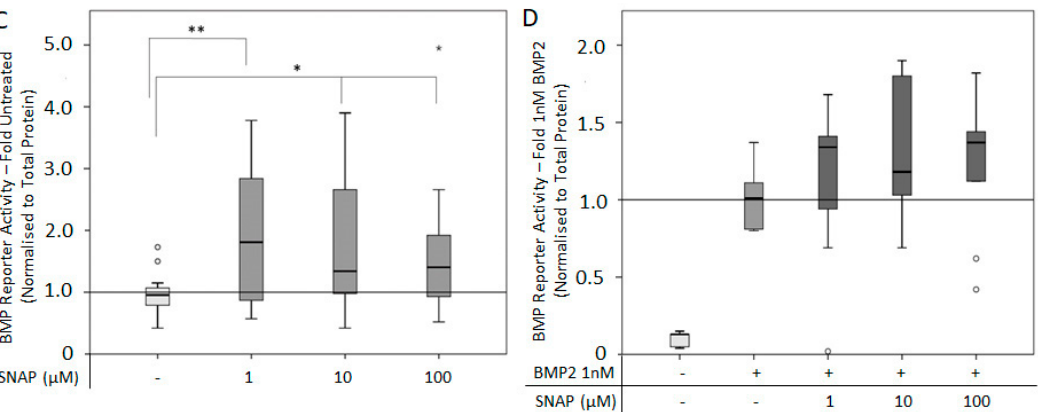
Figure 3. BMP reporter activity after stimulation with the NO donors Deta NONOate and SNAP for